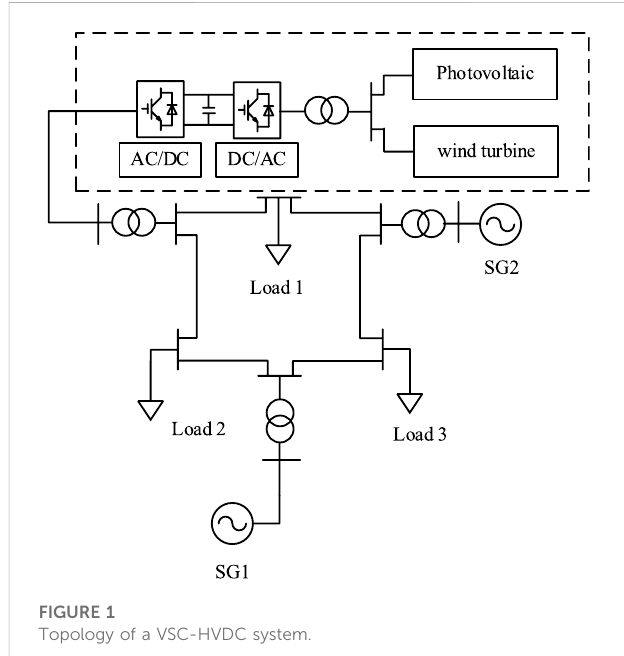
FIGURE 1 Topology of a VSC-HVDC